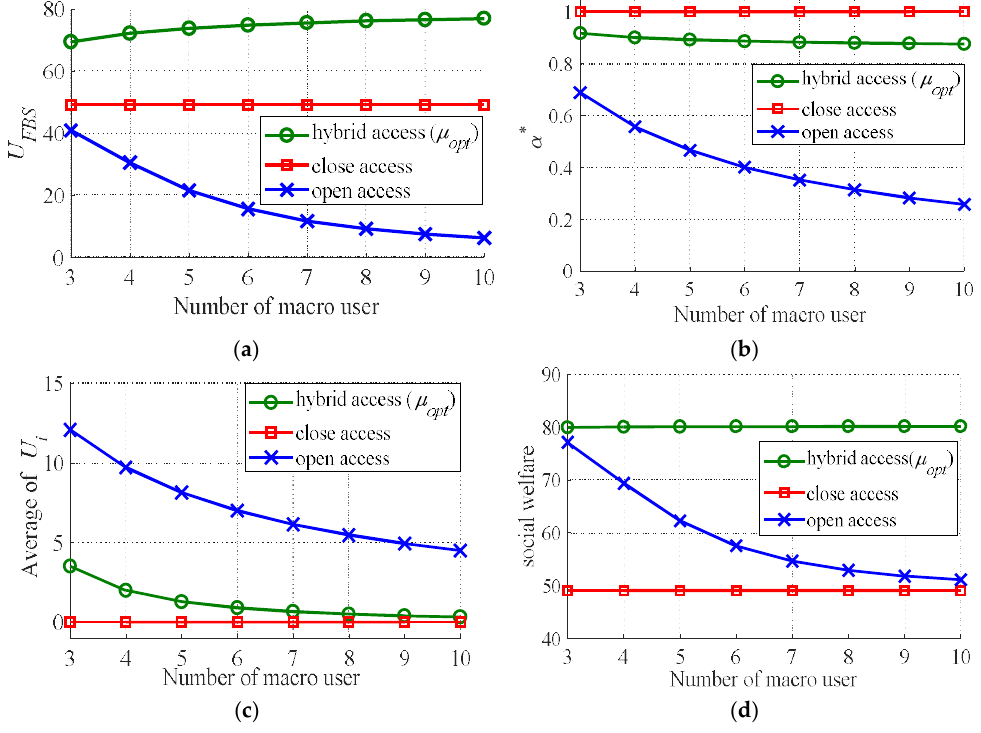
Figure 4. Hybrid, open and closed access comparison. ( a ) Utility of FBS; ( b ) Impact of increasing macro user in α ∗ ; ( c ) Average of U i ; ( d ) Social